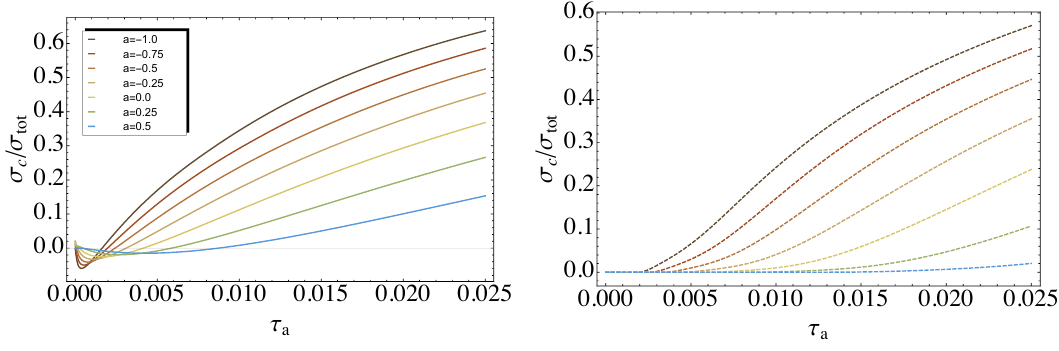
Figure 9 . Predictions for the central values of the integrated cross sections at NNLL 0 accuracy in the low (cid:28) a domain, shown here for seven values of the angularity parameter a . Left : predictions from the purely perturbative cross section. Right : predictions after renormalon subtraction as implemented in eq.